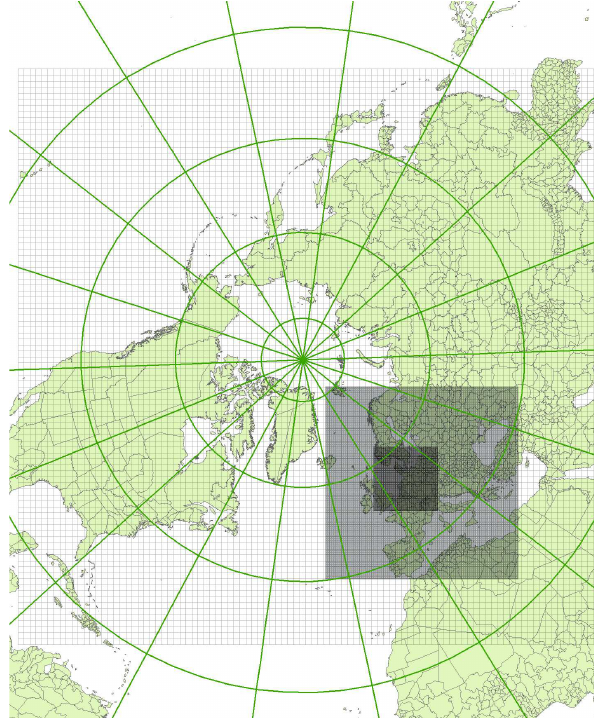
Fig. 2. The DEHM model domain (polar stereographic projection) with two nests. The mother domain covers the Northern Hemi- sphere with a resolution of 150km × 150km. The two nested do- mains included have resolution of 50km × 50km (domain 2) and 16.67km × 16.67km (domain 3),